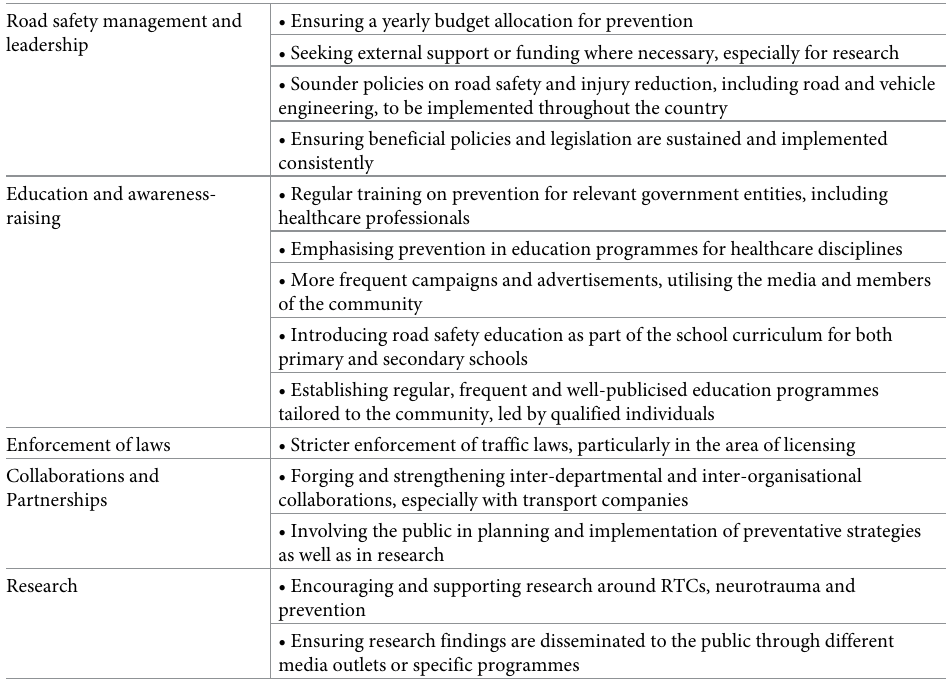
Table 3. Table of recommended strategies for improving prevention of RTCs and RTC-related neurotrauma in Colombia. Road safety management and